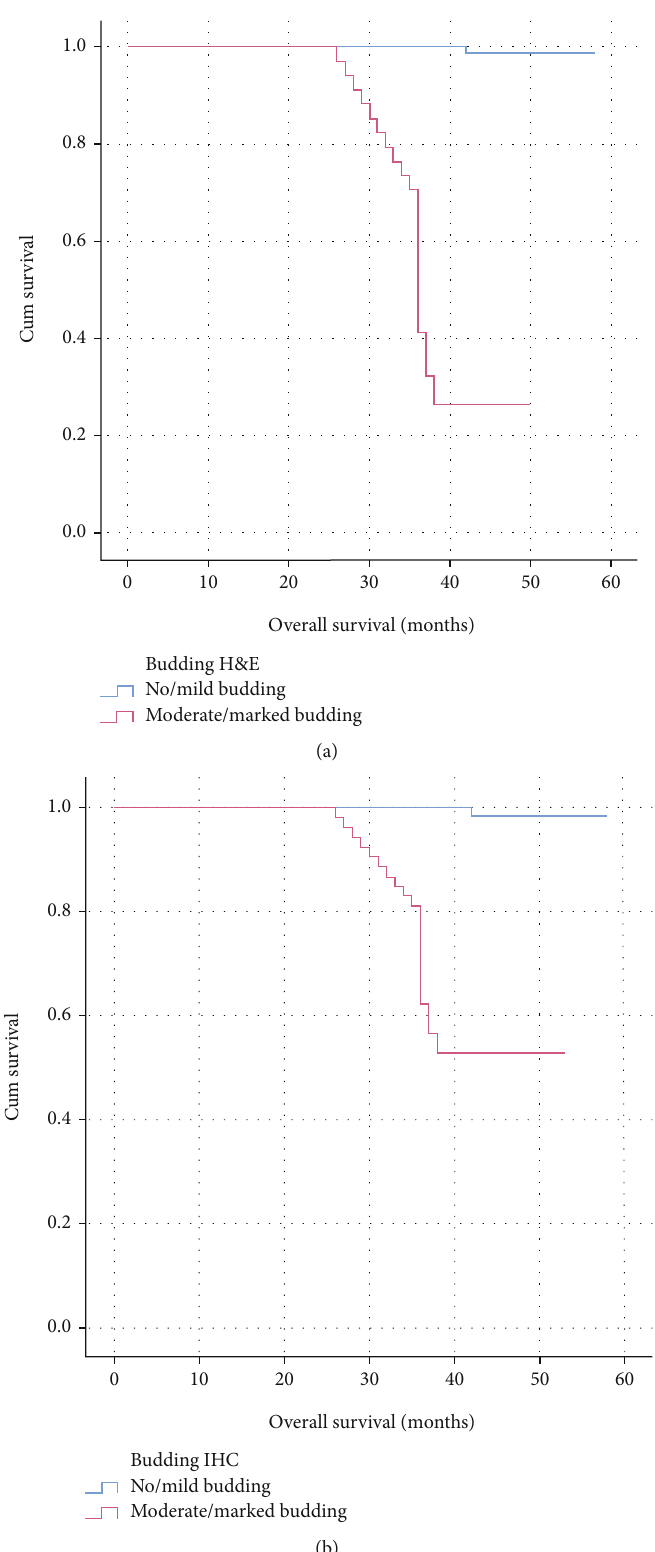
Figure 4: (a) Overall survival in no/mild (low intensity) budding and moderate/marked (high intensity) budding evaluated by H&E; (b) overall survival in no/mild (low intensity) budding and moderate/marked (high intensity) budding evaluated by pancytokeratin